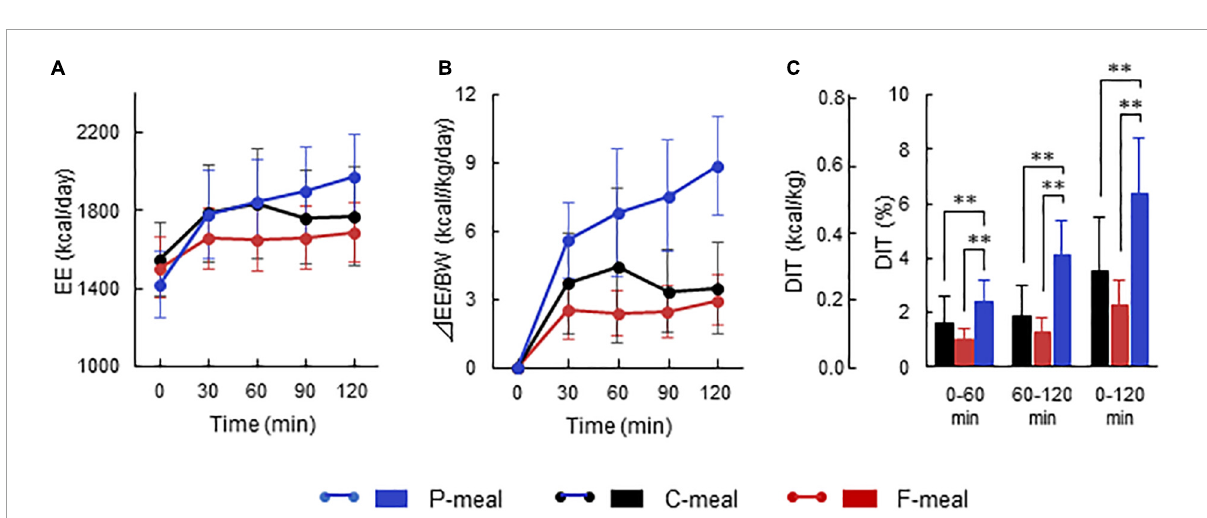
FIGURE2 Energy expenditure and diet-induced thermogenesis after ingestion of test meals. Whole-body energy expenditure (EE) was measured after ingestion of a carbohydrate-rich C-meal (Black) , a protein-rich P-meal (Blue) , and a fat-rich F-meal (Red) at 7.9 kcal/kg body weight (BW). (A) Whole-body EE. (B) Postprandial change in EE calculated as relative to BW. (C) Diet-induced thermogenesis (DIT) calculated as the area under the curve in (B) and expressed as % of ingested energy. Values are expressed as mean ± SD . ∗∗ P <